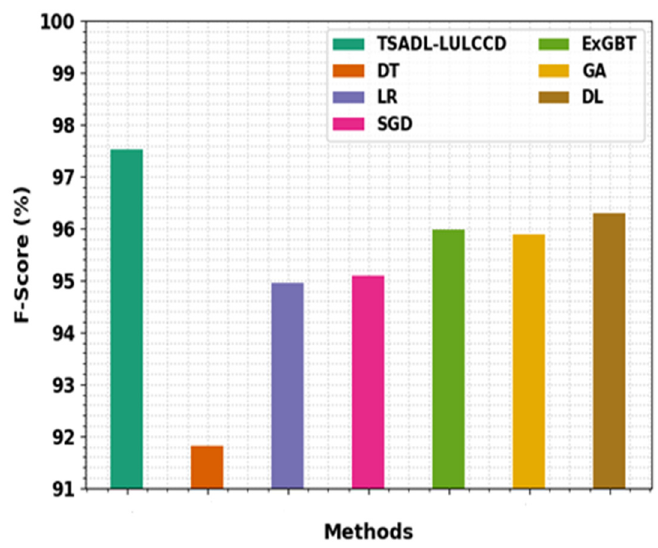
Figure 18. F score analysis of TSADL-LULCCD approach with other Figure 18. 𝐹 (cid:3046)(cid:3030)(cid:3042)(cid:3045)(cid:3032) analysis of TSADL-LULCCD approach with other approaches.